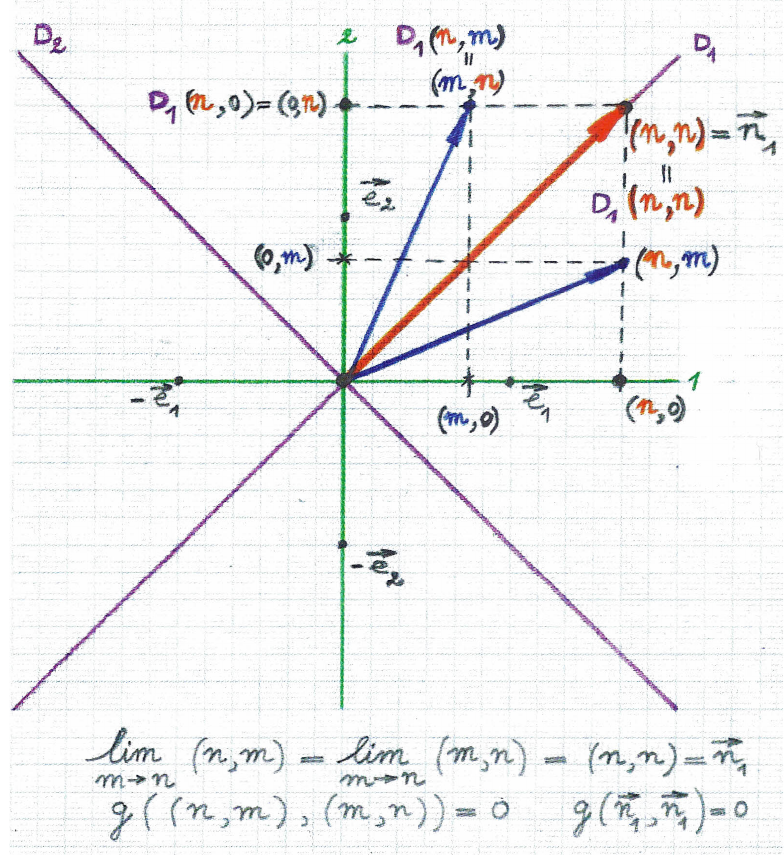
Figure 4. Auto-orthogonal